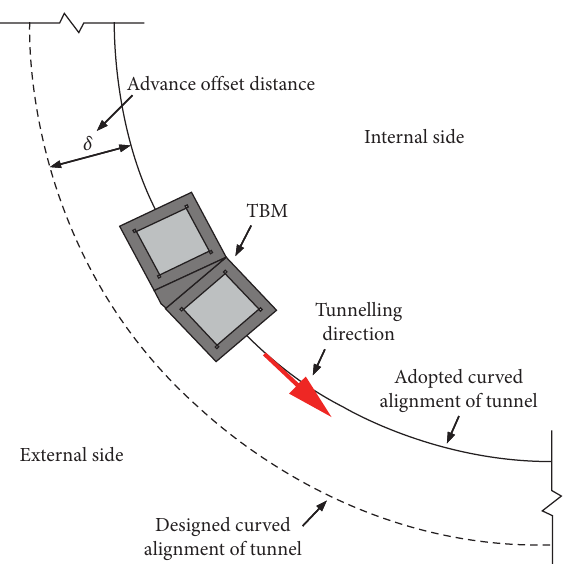
Figure 13: Schematic diagram of advance offset for tunnel